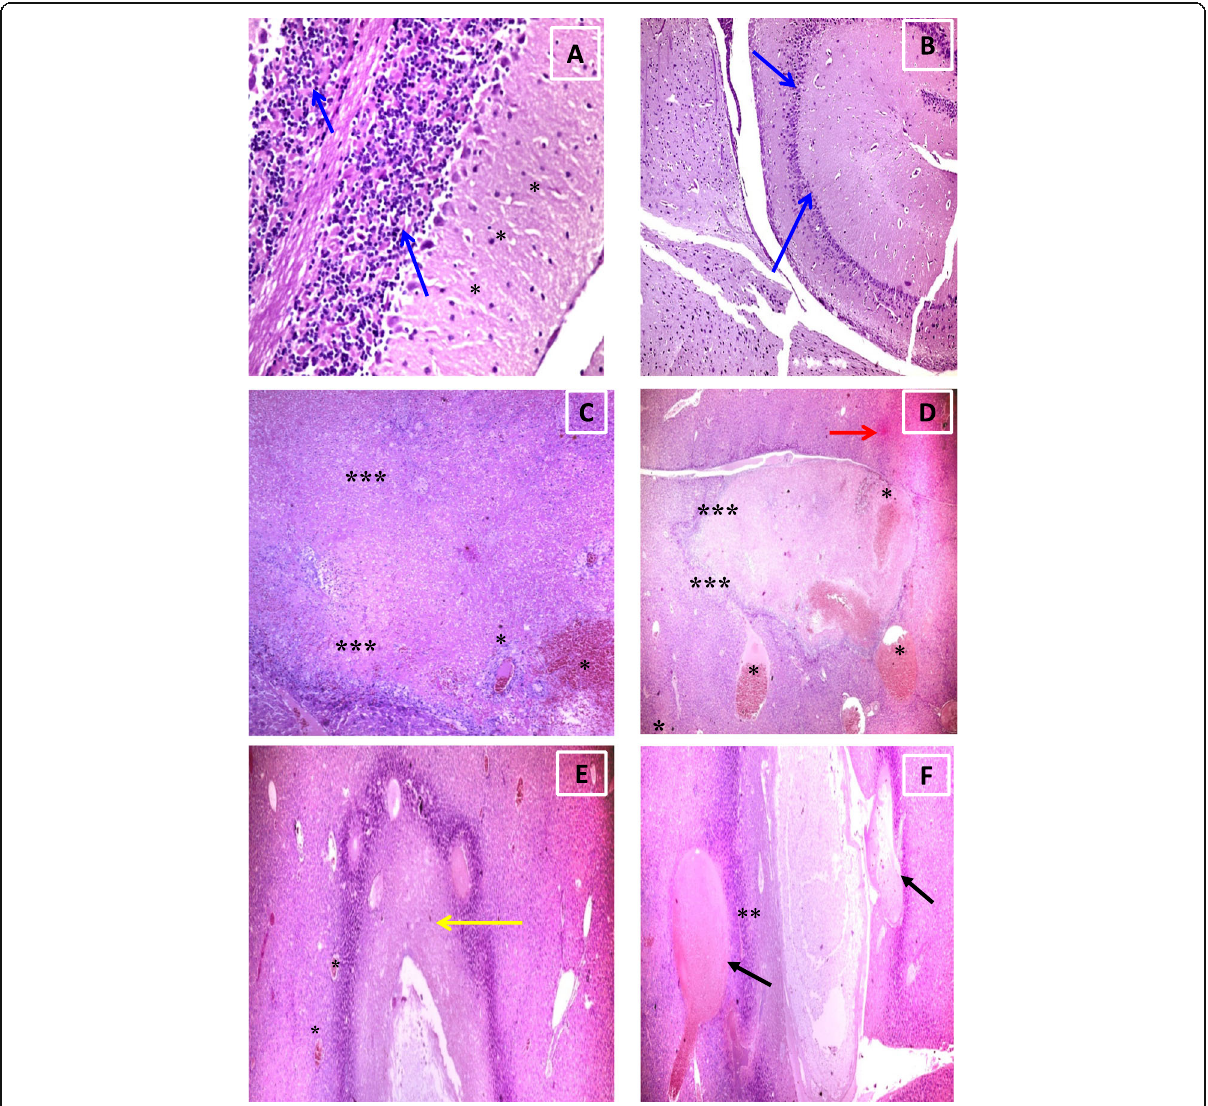
Fig. 4 Histopathological of the brain stained with hematoxylin and eosin in a control groups of rat showing normal arrangement of layers of neurons (blue arrow) and neuronal fibers (*); b cross-section of rat brain treated with L -carnitine (10 mg/kg) showing normal white matter with normal neurons (blue arrow) and neuronal fibers (*); c aspartame low dose group (75 mg/kg) showing moderate area of hemorrhage (*) and necrosis (***) in the brain; d aspartame high dose rats (150 mg/kg) showing large area of hemorrhage (*) and necrotic areas of the brain (***) with congested area (red arrow); e low dose of aspartame and L -carnitine-treated group showing very reduced congested area (*) with normal neural fibers (yellow arrow); f high dose of aspartame and L -carnitine showing the recovery of the congested area with moderate area of necrosis (black arrow) with normal appearance to fibers (**) and reduced necrotic neurons (×